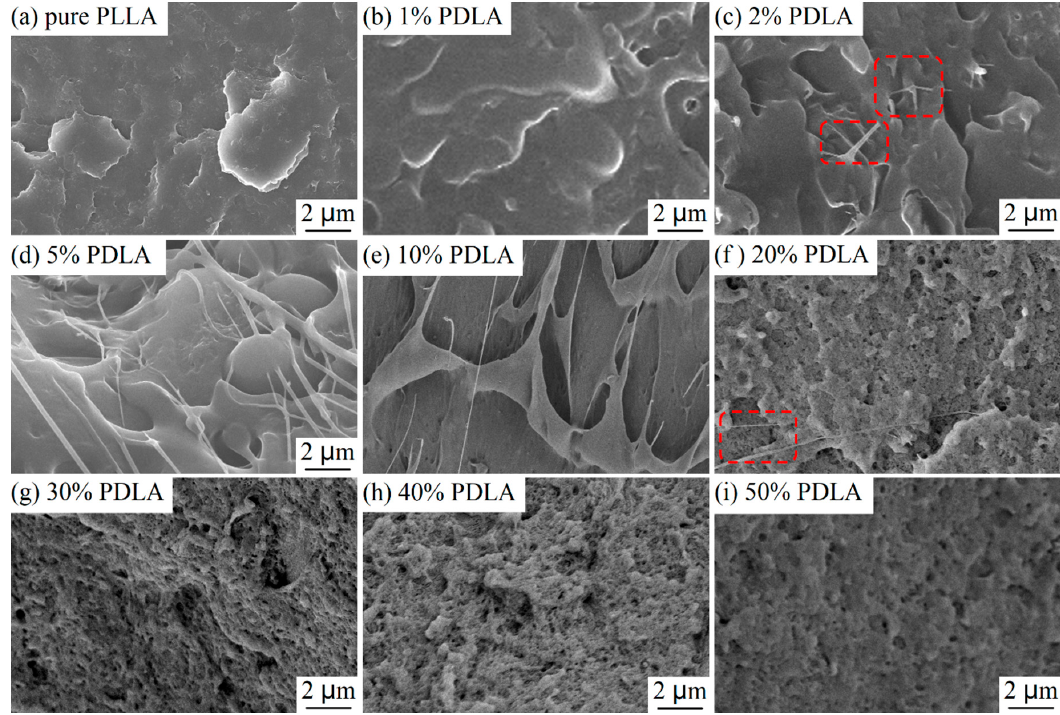
Figure 3. FE-SEM images of the morphologies of extrusions of ( a ) pure PLLA and ( b – i ) PDLA/PLLA blends with different PDLA contents.